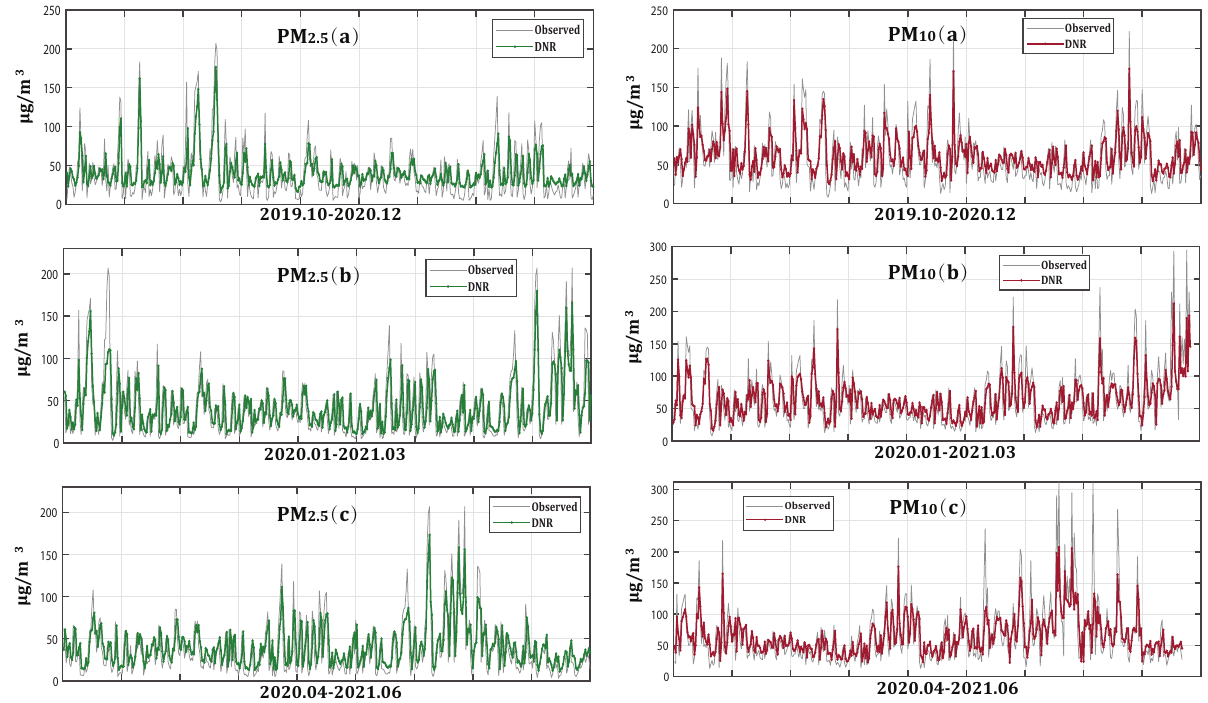
Figure 5. Air quality time series training and estimation results of DNR for each